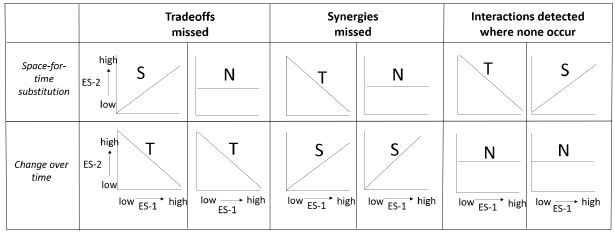
Fig. 3 . Boxes represent scatter plots showing the relationship between two ecosystem services. Positively correlated ecosystem services are considered synergies, negatively correlated ecosystem services are trade-offs, and uncorrelated ecosystem services do not interact. S-Synergy, T-Trade-off, N-No interactions. Comparing space-for-time and change-over-time approaches, a trade-off can be missed when the space-for-time approaches show no interaction or a synergy, but the change- over-time approach shows a trade-off (Panel A). Synergies missed occur when space-for-time approaches show either a trade-off or no interaction, but the change-over-time approach shows a synergy (Panel B). Interactions detected where none occur are examples of when space-for-time approaches show a synergy or a trade-off, but change-over-time show no interaction (Panel